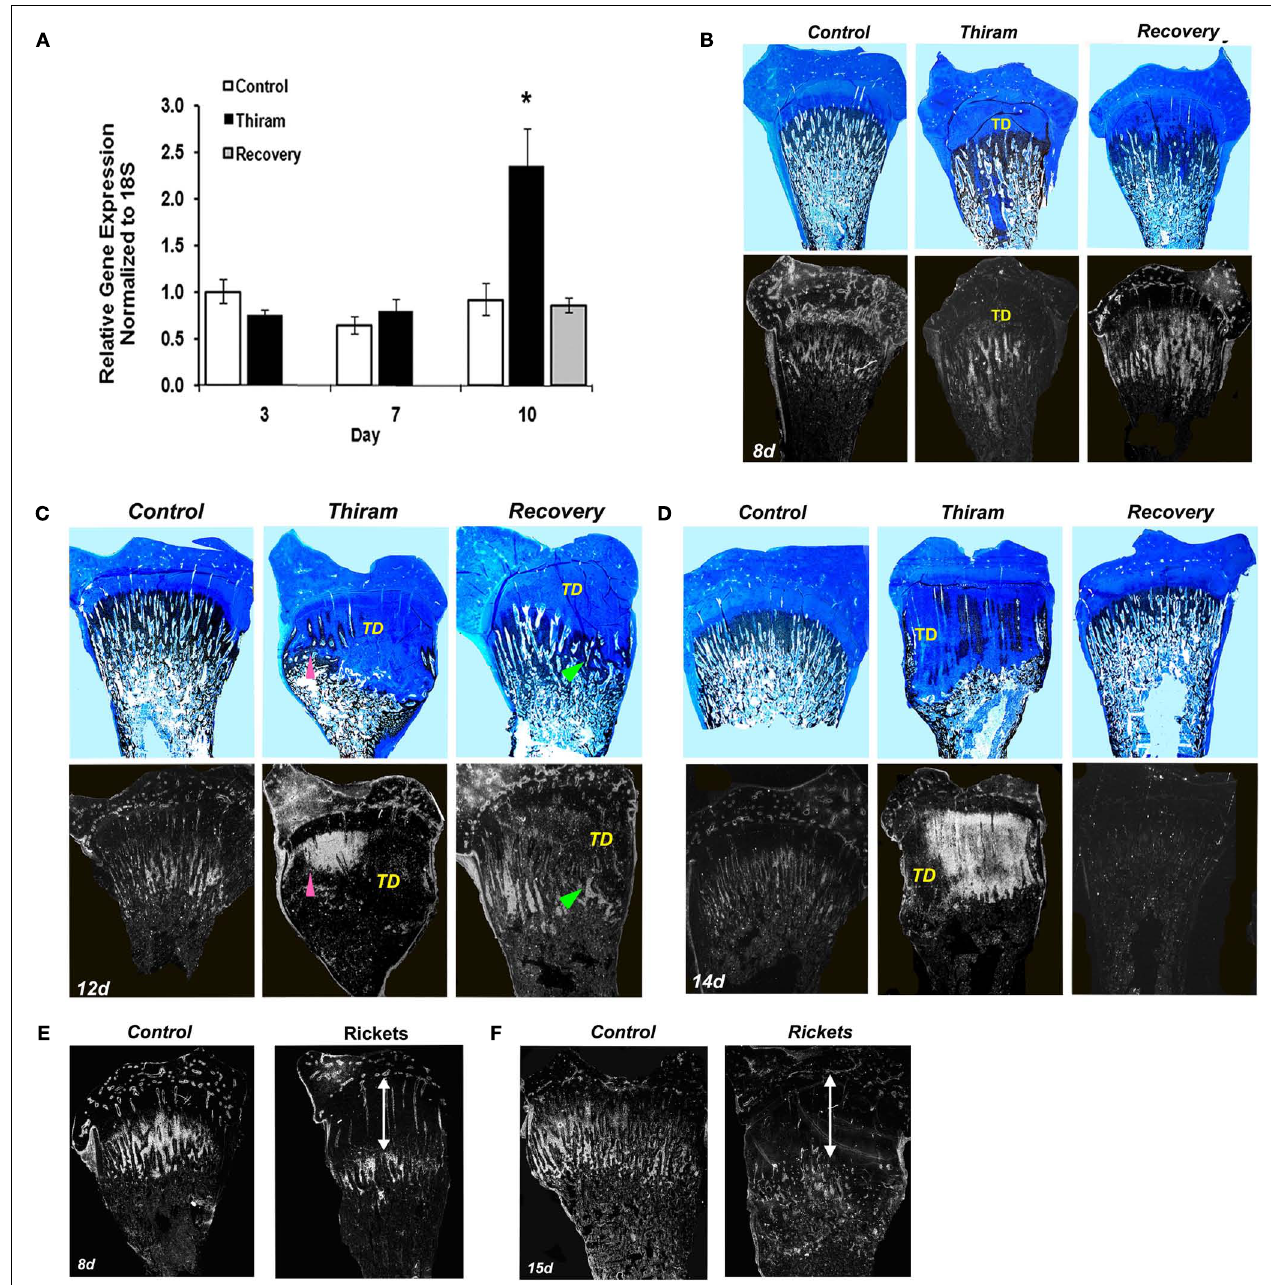
hybridization with 35 S-labeled riboprobes of the avian MGP (lower panels; × 7.5). (B) No MGP expression in the lesion area. (C,D) Arrows pointing MGP expression in areas that show signs of healing and resorption.TD, tibial dyschondroplasia. (E,F) Rickets was induced by vitamin D deficiency. MGP expression was studied on days 8 (E) and 15 (F) by in situ hybridization. No MGP expression was found in the rachitic lesion (marked by an arrow), its expression is “pushed” to the new chondro-osseous